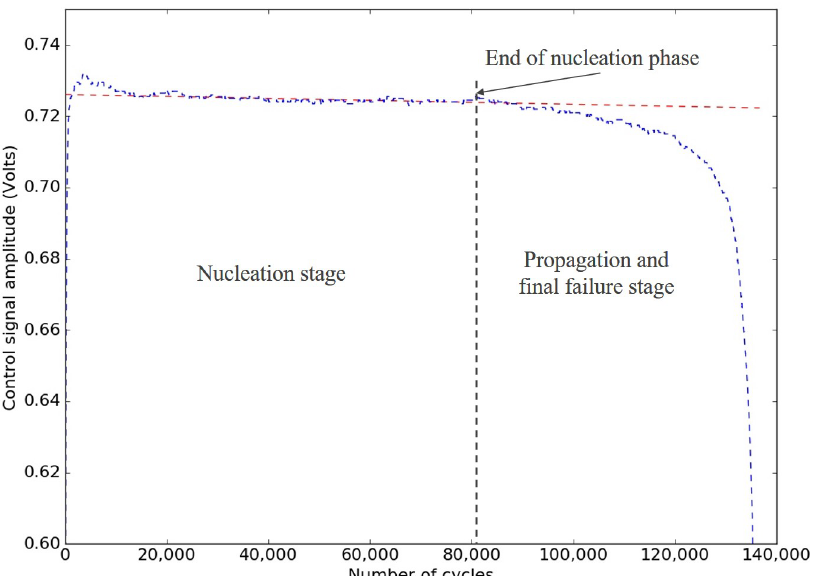
Figure 10. Nucleation and propagation stage of a fine finished wrought specimen displaced at 0.200 mm